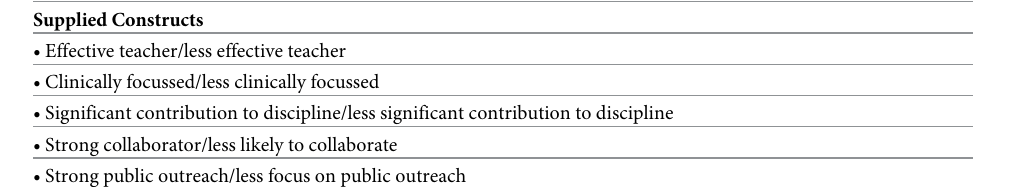
Table 2. Supplied